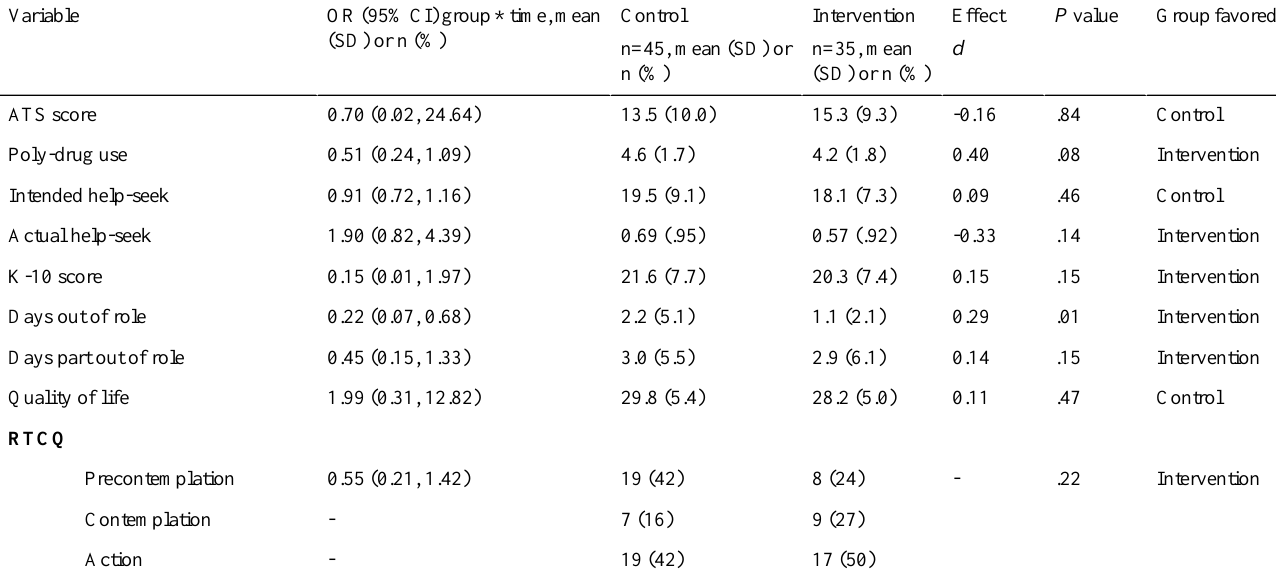
Table 2. OR for group by time interaction plus posttest outcomes and pre/posttest effect sizes. Group by time interaction is adjusted for the SDS score at baseline and time varying actual help-seeking. Effect size is the difference in pre/post means/common pretest SD with bias correction factor